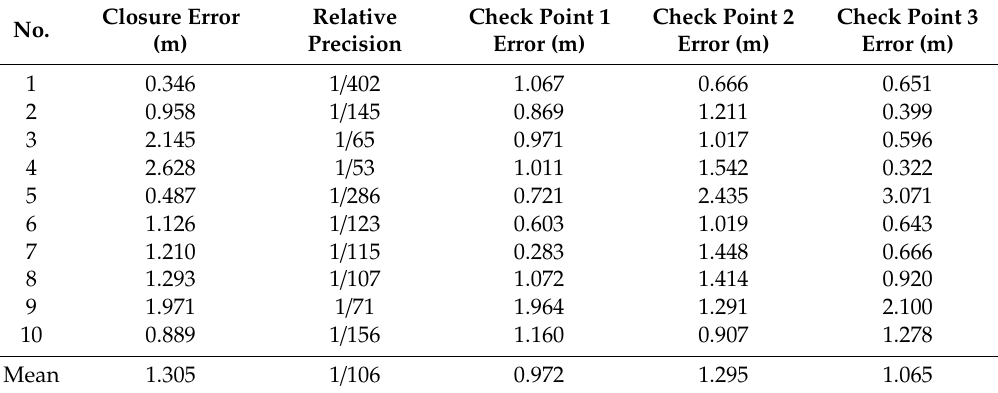
Table 3. Xie’s method.